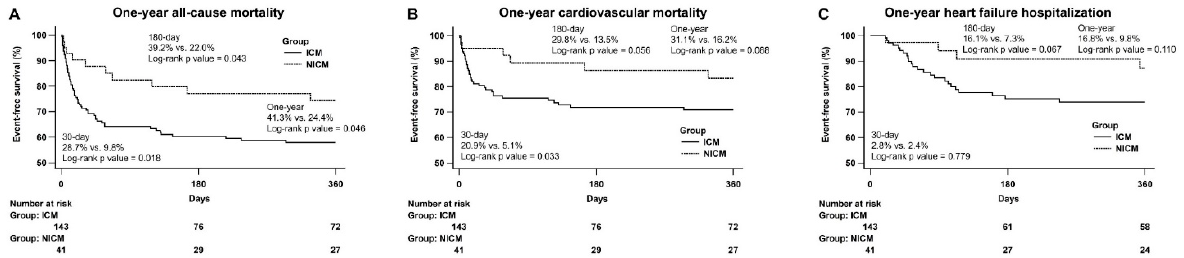
Figure 2. Kaplan–Meier curves of HF hospitalization, CV mortality, and all-cause mortality between the two groups: ( A ) a Kaplan–Meier curve of all-cause mortality showed difference at 30 day, 180 day, and 1 year between the ICM and NICM groups; ( B ) a Kaplan–Meier curve of cardiovascular mortality showed difference at 30 days and a trend at 180 days and 1 year between the ICM and NICM groups; ( C ) a Kaplan–Meier curve of HF hospitalization did not differ at 30 days, 180 days, and 1 year between the ICM and NICM groups. ICM: ischemic cardiomyopathy; NICM: non-ischemic cardiomyopathy.